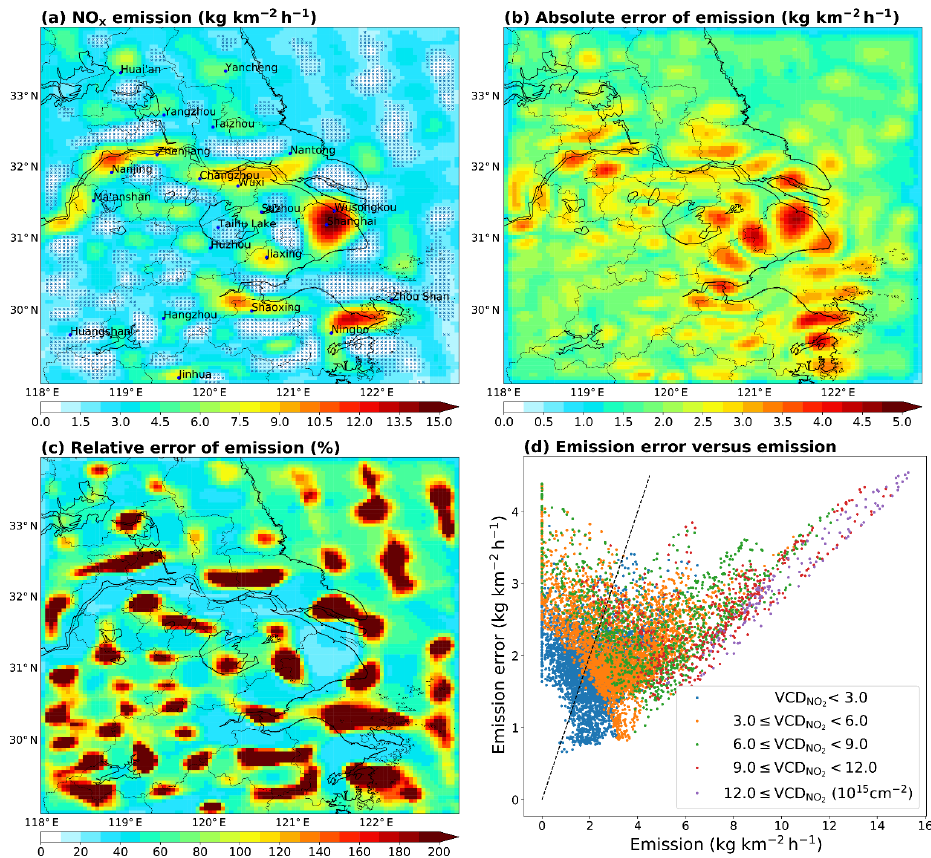
Figure 5. (a) Our NO x emissions from anthropogenic, biomass burning and soil sources together. The blue crosses indicate where the relative errors exceed 100%. (b) Absolute errors (1 σ ) of our NO x emissions. (c) Relative errors of our emissions. (d) Absolute errors (1 σ ) of NO x emissions as a function of NO x emissions at individual grid cells. Data points are colored according to the magnitudes of POMINO NO 2 VCDs. The dashed line indicates an error of